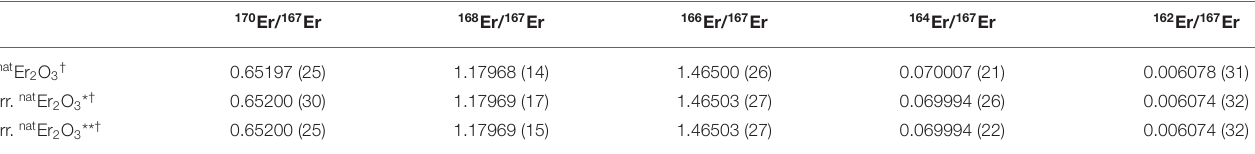
TABLE 3 | Comparison of the isotope ratios obtained by ICP-MS for natural and proton-irradiated Er 2 O 3 samples. 170 Er/ 167 Er